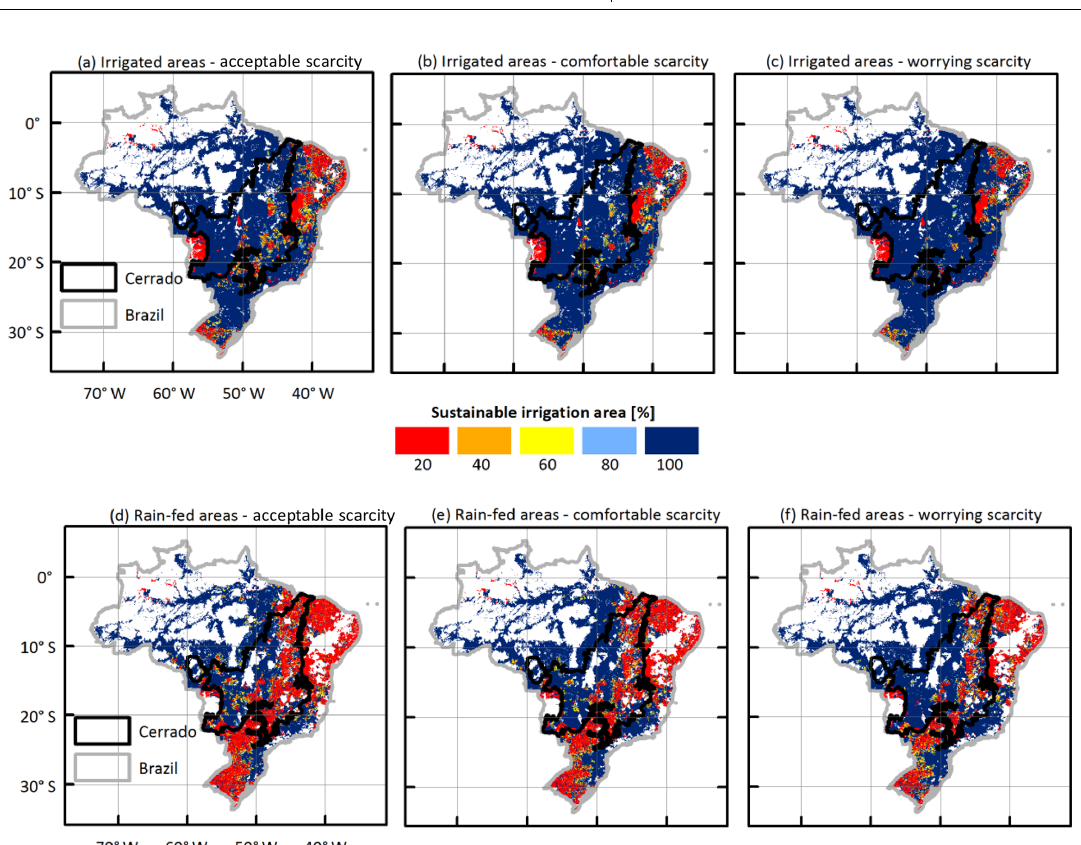
Figure 4. Fraction of current irrigated areas (a, b, c) and potentially irrigated areas (d, e, f) which can be sustainably irrigated according to a target blue-water scarcity level of acceptable (a, d) , comfortable (b, e) and worrying (c, f) .